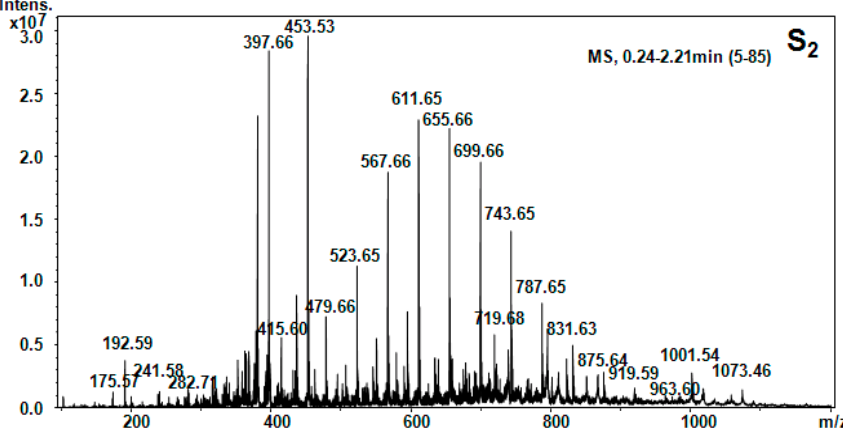
Figure 4. Positive ion mode nano-ESI-Chip-MS for S 2 hellebore fraction.